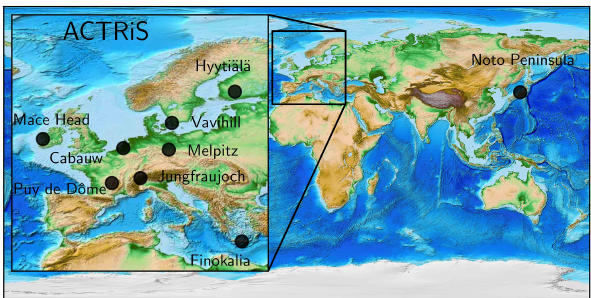
Figure 1. Map showing the location of the measurement sites used in this